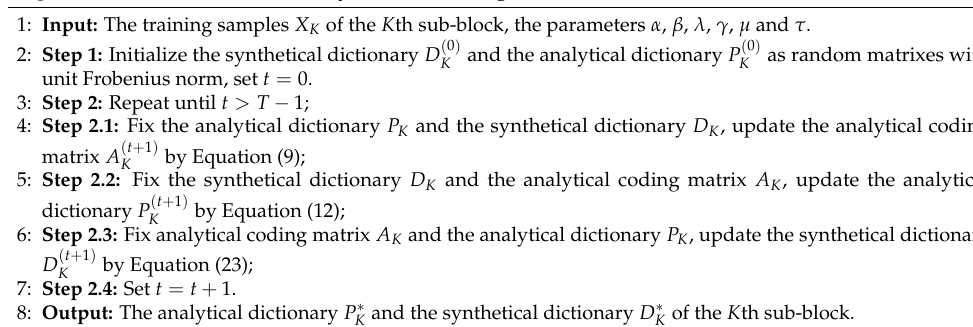
Algorithm 1 Robust Dictionary Pair